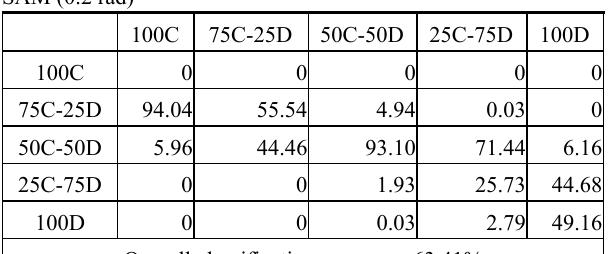
Overall classification accuracy: